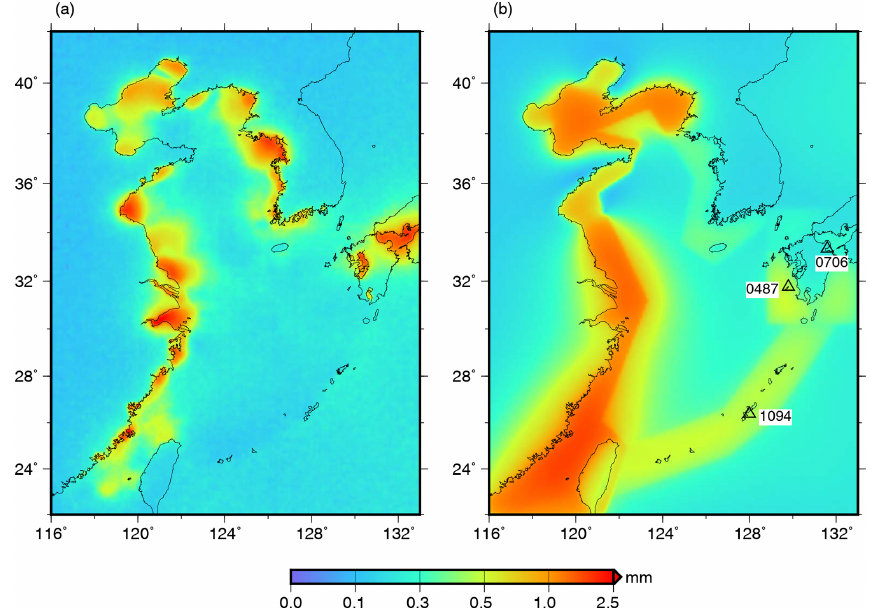
Figure 3. (a) The standard deviation of M 2 vertical OTL displacements, computed using the nine ocean tide models and an elastic PREM Green’s function. (b) The M 2 vertical OTL errors per grid point according to Eq. (4), using the RMS errors in NAO99Jb based on comparisons with tide gauges and an elastic PREM Green’s function. The triangles (and accompanying names) denote GPS sites which are considered for detailed OTL computation analysis.